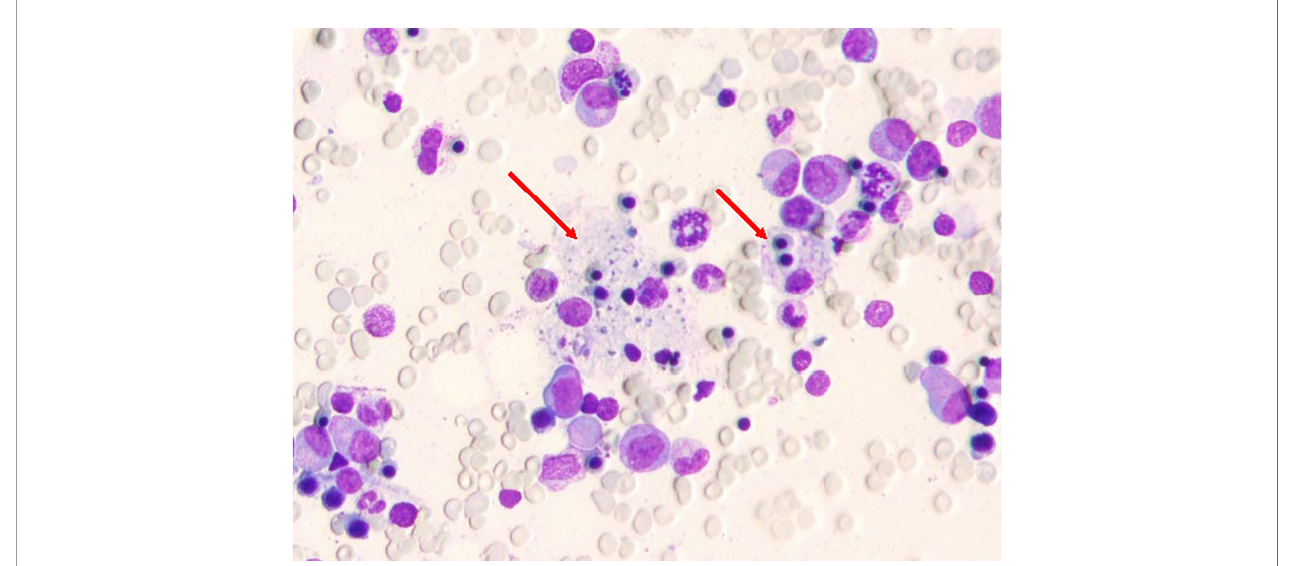
FIGURE 2 | Bone marrow smear carried out when hemoglobin was lowest; the arrow indicates hemophagocytic